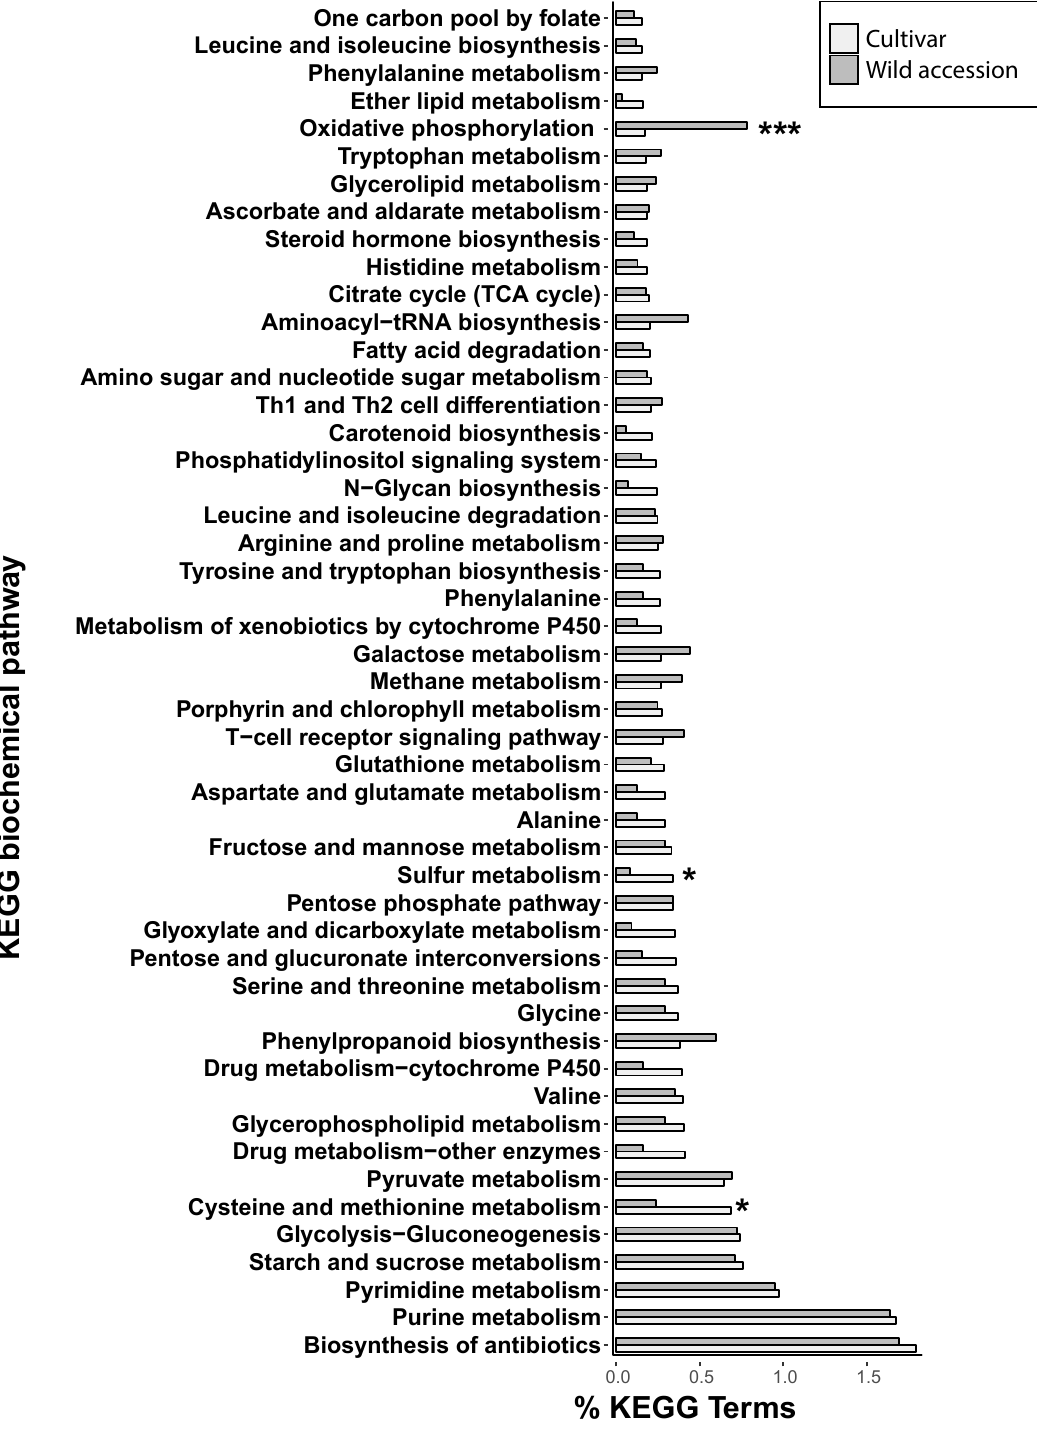
Figure 5. Percentages of Kyoto encyclopedia of genes and genomes (KEGG) biochemical pathway terms associated with gene-RE pairs in cultivars and wild accessions of H. annuus . Asterisks indicate PERMANOVA significance between cultivars and wild accessions: *** p < 0.001; * p <